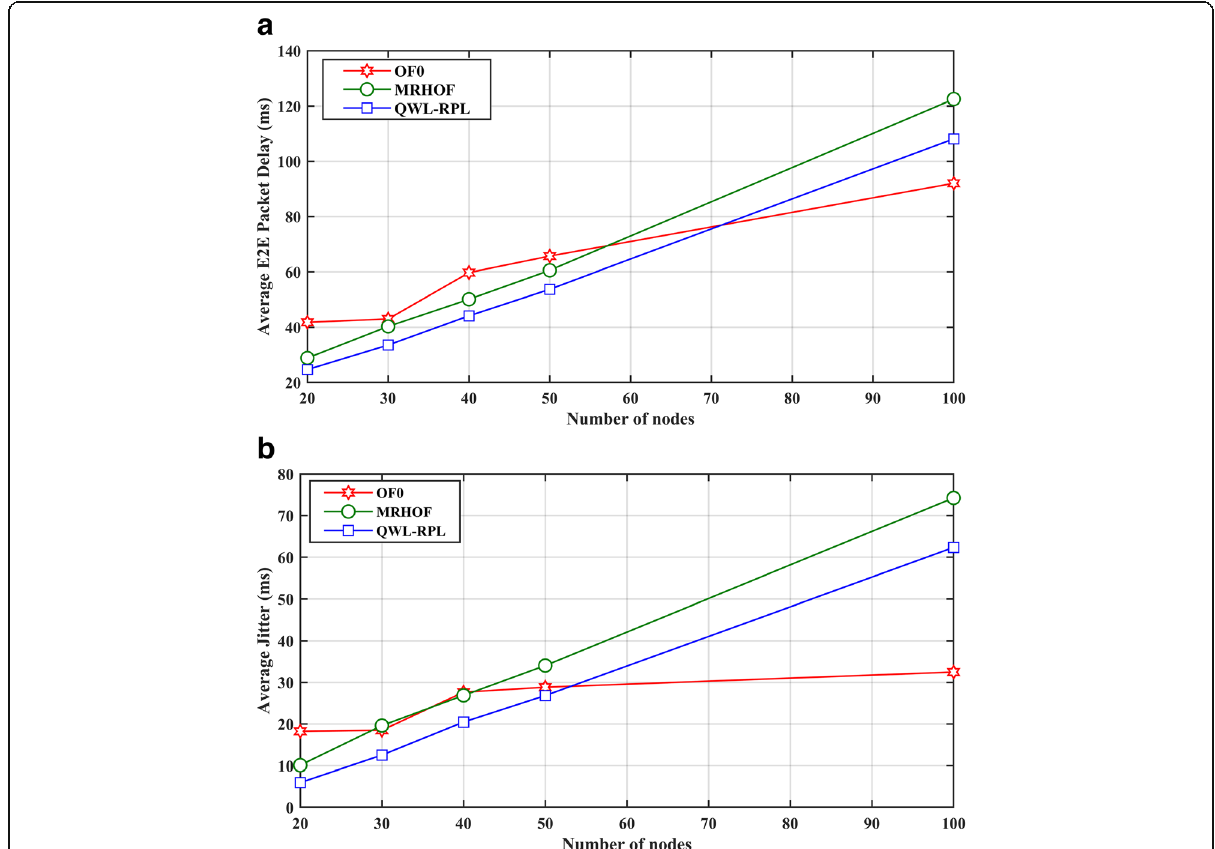
Fig. 10 Simulation analysis for scenario II for the a average E2E delay (ms) and b average jitter versus number of